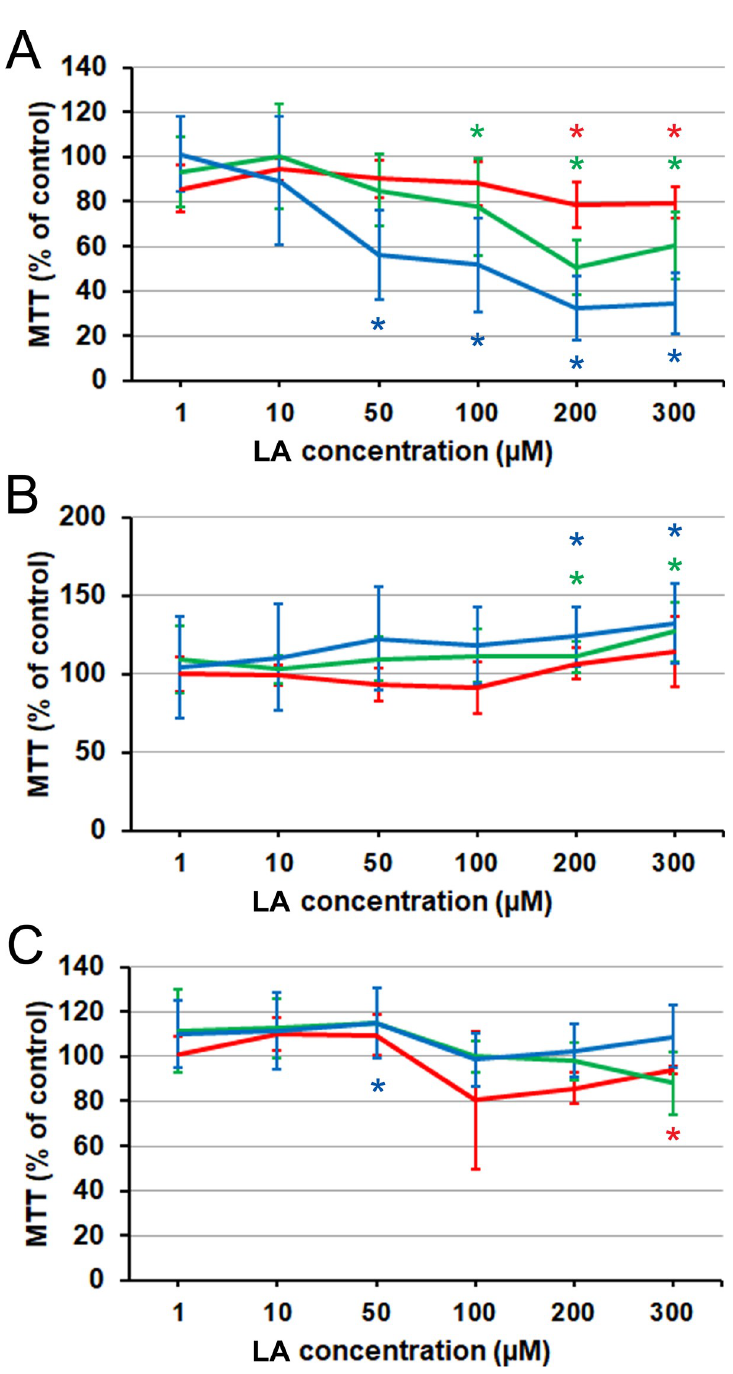
Fig 5. Effect of LA on prostate cancer cells proliferation and viability as measured by MTT assay. (A) PC3 cells. (B) LNCaP cells. (C) C4-2 cells. Red line: 24 h. Green line: 48 h. Blue line: 72 h. Error bars: standard deviation. Asterisk: difference from the control is significant on the significance level 0.05, corrected for multiple comparisons. C4-2 24 h data: each point is the average of n = 3 cell cultures. All other data: each point is the average of n = 9–21 cell